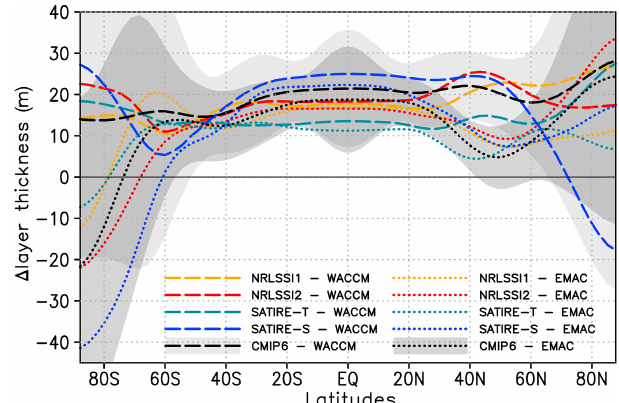
Figure 10. Annual mean zonally averaged 11-year solar cycle re- sponse in layer thickness from 100 to 10hPa in metres for WACCM (long dashed) and EMAC (dotted) with prescribed SSI data sets NRLSSI1(CMIP5) (yellow), NRLSSI2 (red), SATIRE-S (blue), SATIRE-T (light blue), and CMIP6 (black). The 95% uncertainty range is given for simulations with the CMIP6 data set for WACCM (light grey shaded) and EMAC (dark grey shaded).